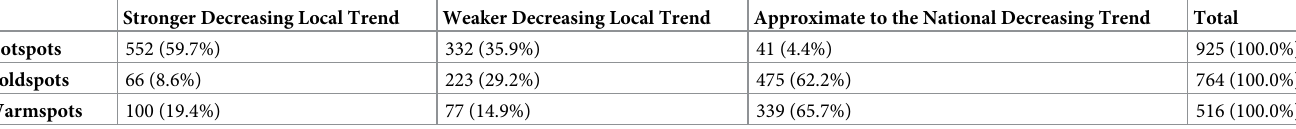
Table 1. Number of counties resulting from the cross classification (2,205